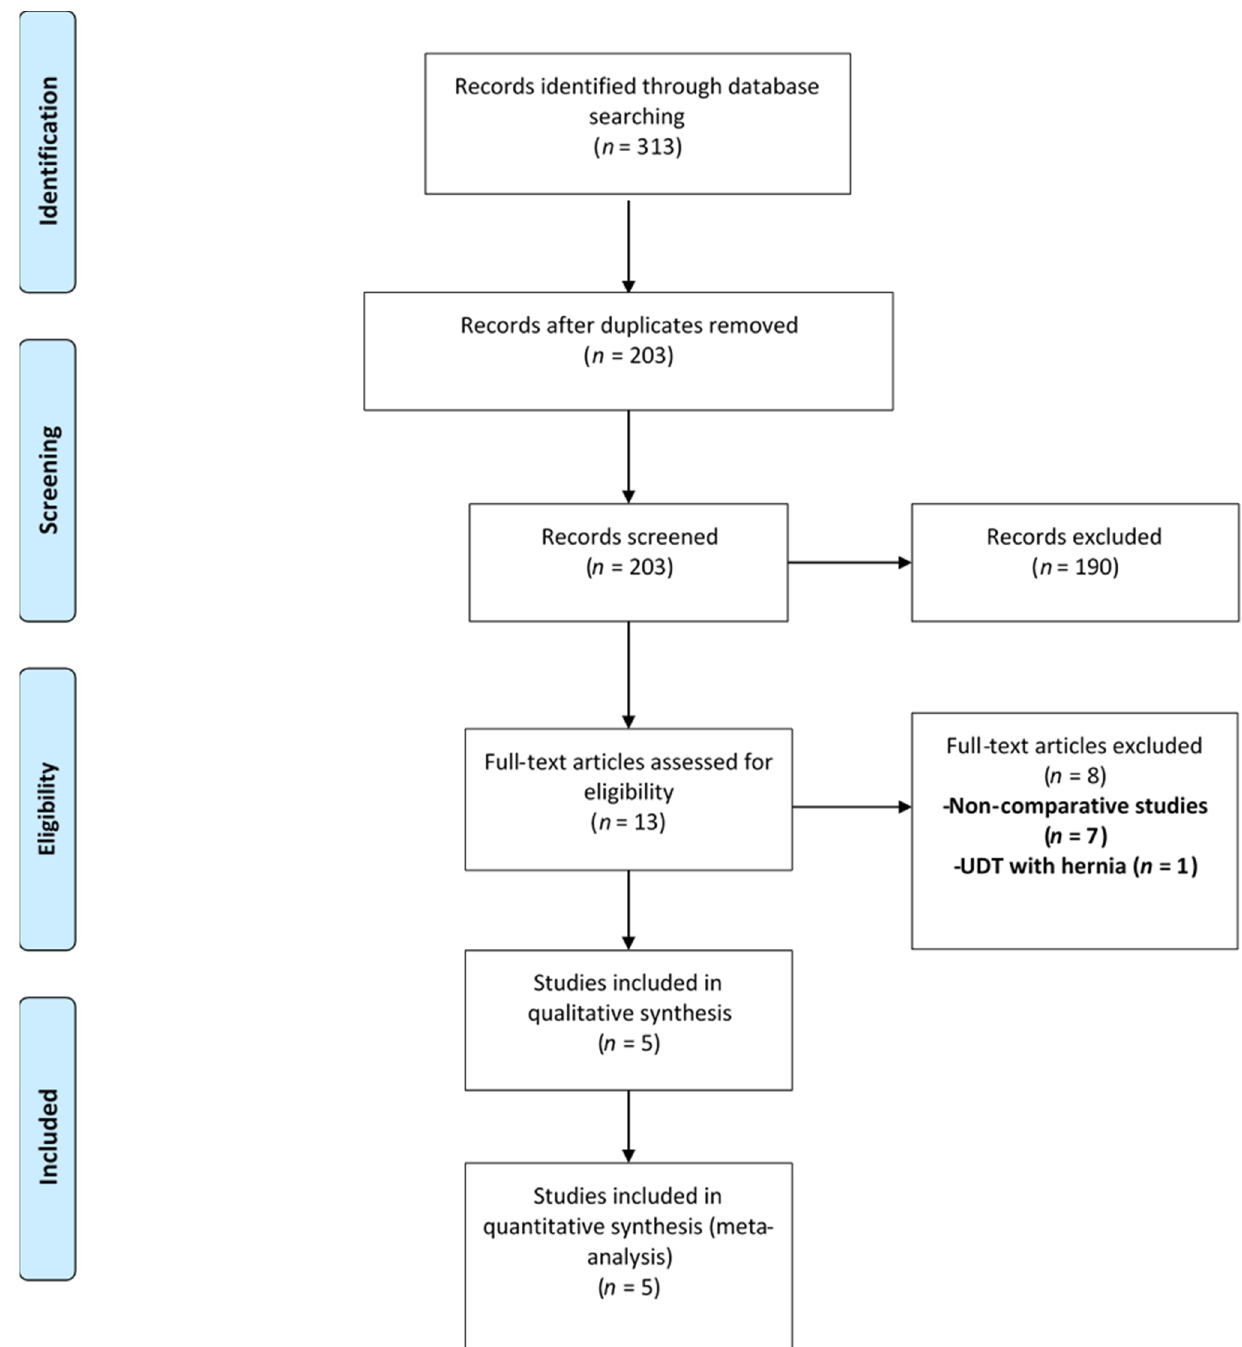
Figure 1. Selection of the relevant studies using the Preferred Reporting Items for Systematic Review and Meta-Analysis (PRISMA) flow diagram. Legend: UDT—Undescended testicle.